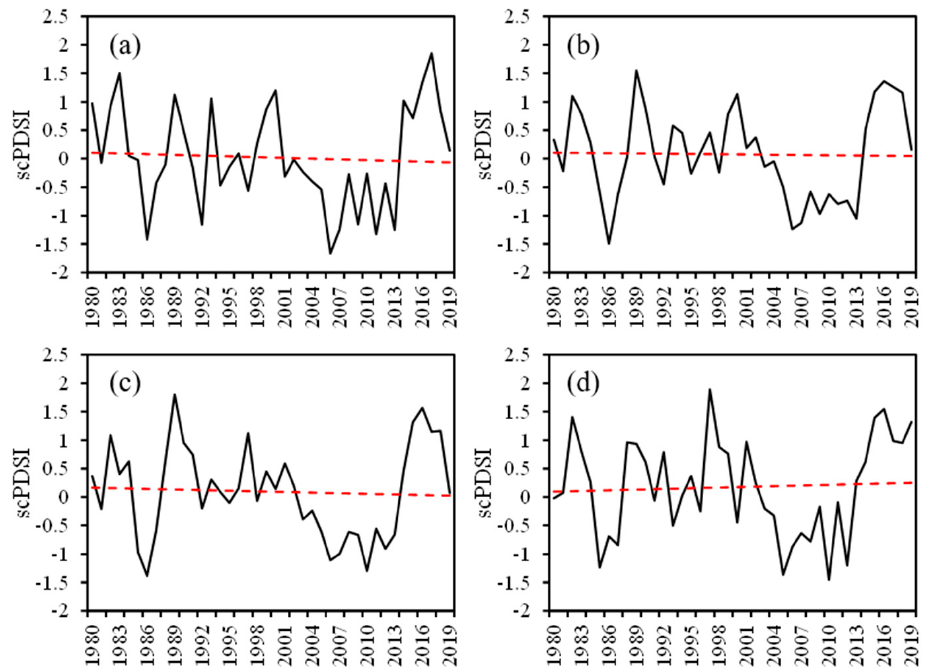
Figure 3. Self–calibrating Palmer Drought Severity Index (scPDSI) in different seasons in the YRB during the period 1980–2019. The red dotted line shows the trend. ( a ) Autumn, ( b ) winter, ( c ) spring, ( d ) summer.